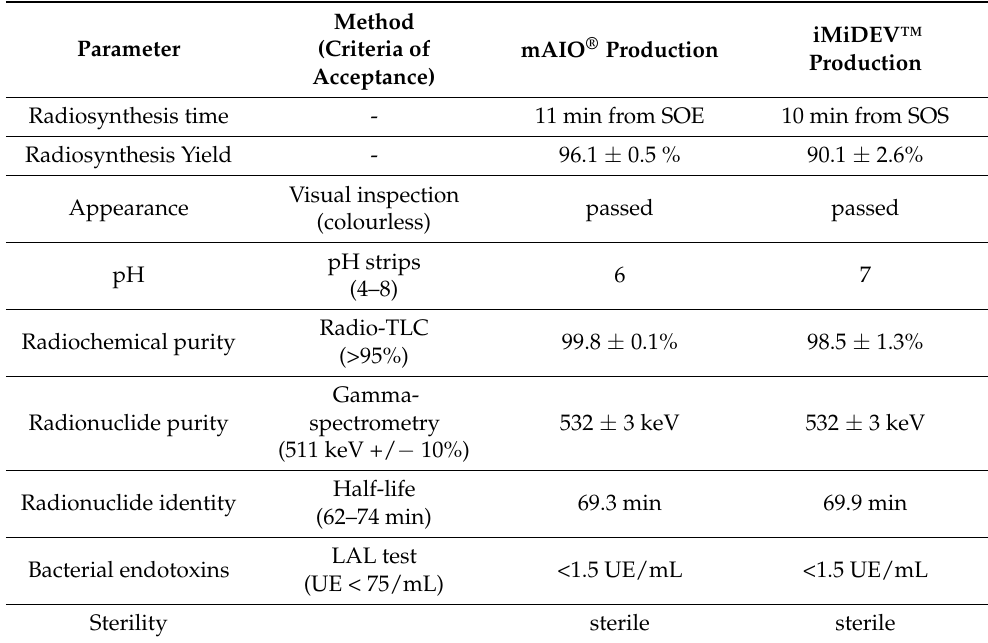
Table 7. Results of validation of [ 68 Ga]Ga-citrate production with three consecutive batches.